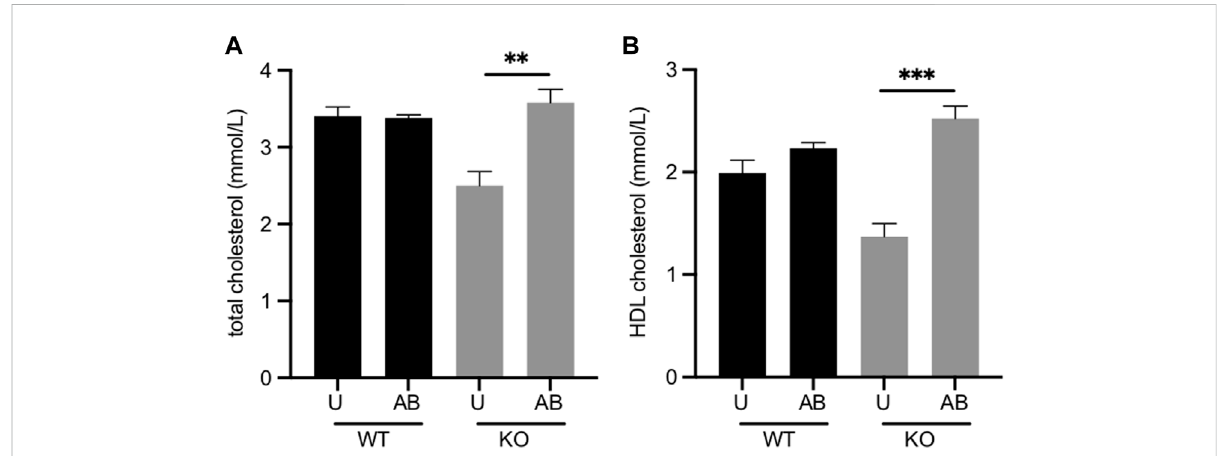
FIGURE 2 Effect of antibiotic treatment on plasma concentrations of total cholesterol. (A) and HDL cholesterol. (B) Male Fmo5 − / − (KO) or wild-type (WT) mice(30-weeksold)weretreatedwithantibiotics intheirdrinkingwaterfor 2weeks(AB)orwereuntreated(U).WT, n =4;WT +AB, n =4;KO, n =4; KO + AB, n = 5. Data are expressed as means ± SEM. ** p < 0.01, *** p <